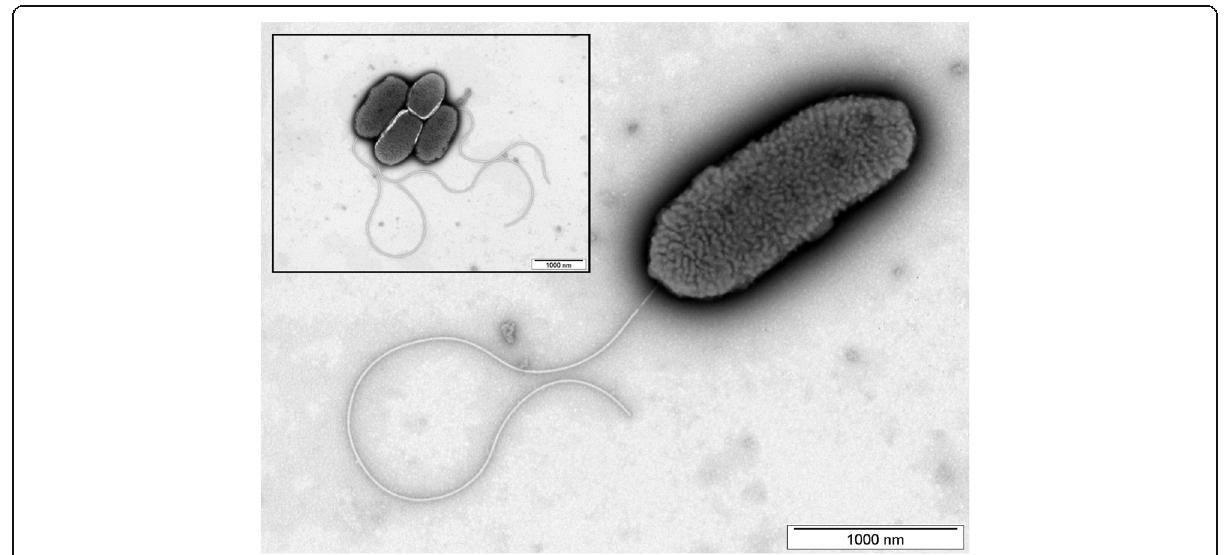
Fig. 1 Transmission electron photomicrograph of P. alcaliphila